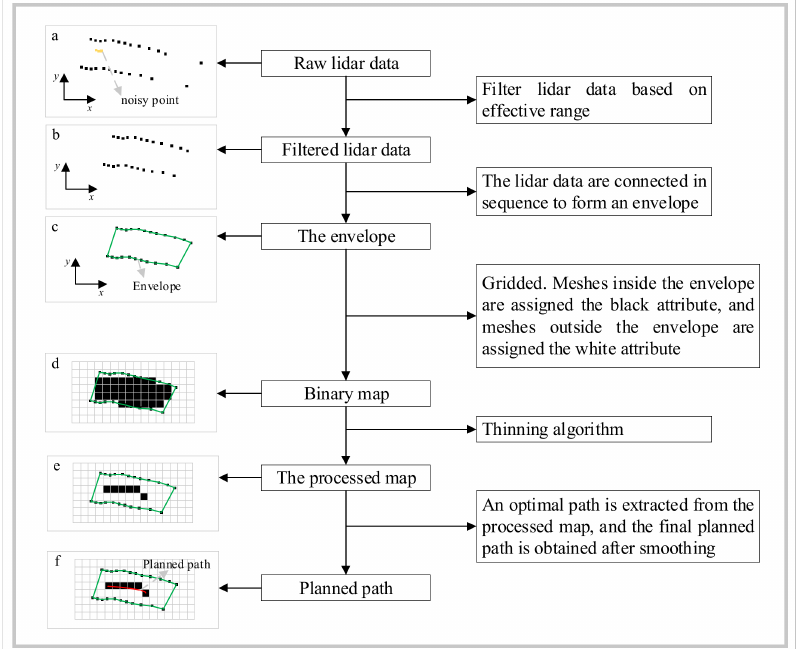
Figure 4. Flowchart of the proposed algorithm. ( a – f ) are the schematic diagrams corresponding to each step of the proposed